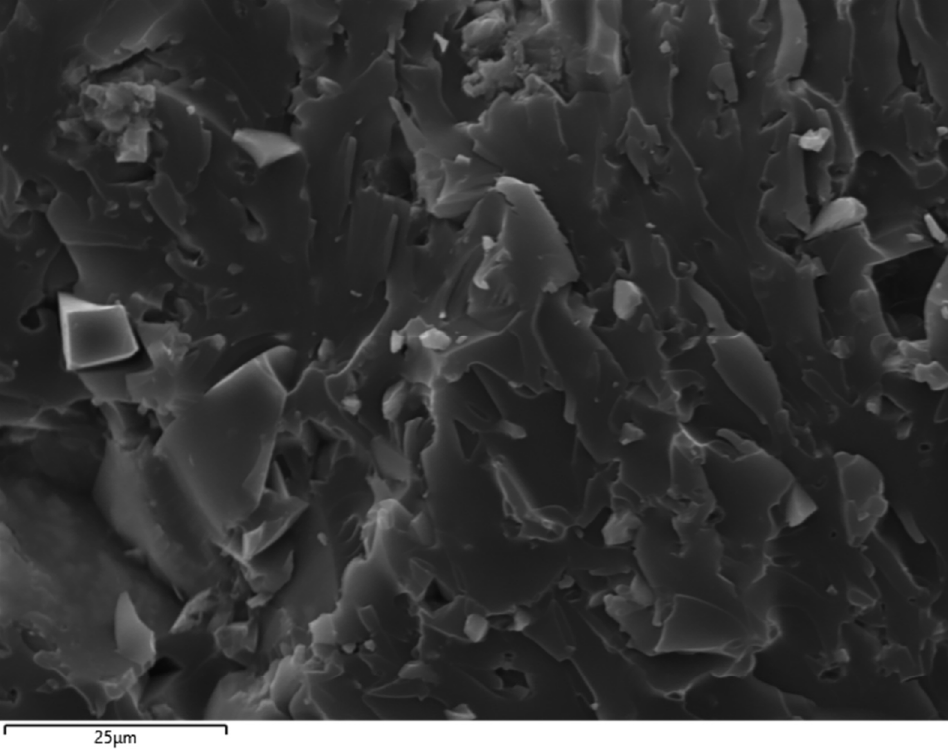
Figure 4. Elemental mapping for Eb150 + 40%G UV-LED cured film. 3.3. Thermal Behavior DSC analyses were performed in order (i) to further support the completeness of the UV-LED curing process and (ii) to evaluate the glass transition temperature ( T g ) values and their possible changes in the presence of increasing phosphate glass powder loadings. For this purpose, a heating/cooling/heating thermal cycle was conceived as detailed in the Materials and Methods Section. The first heating up was chosen only for confirming the absence of exothermal peaks that would have been a clear indication of incompleteness of the curing process, hence further supporting the FTIR-ATR outcomes.